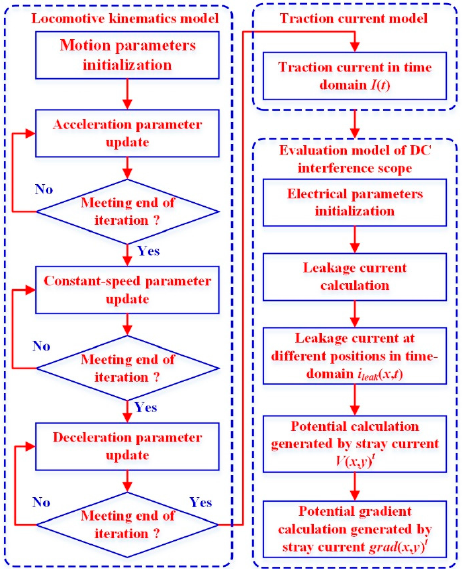
Figure 5. Calculation flow of time-domain evaluation model of DC interference generated by stray current.